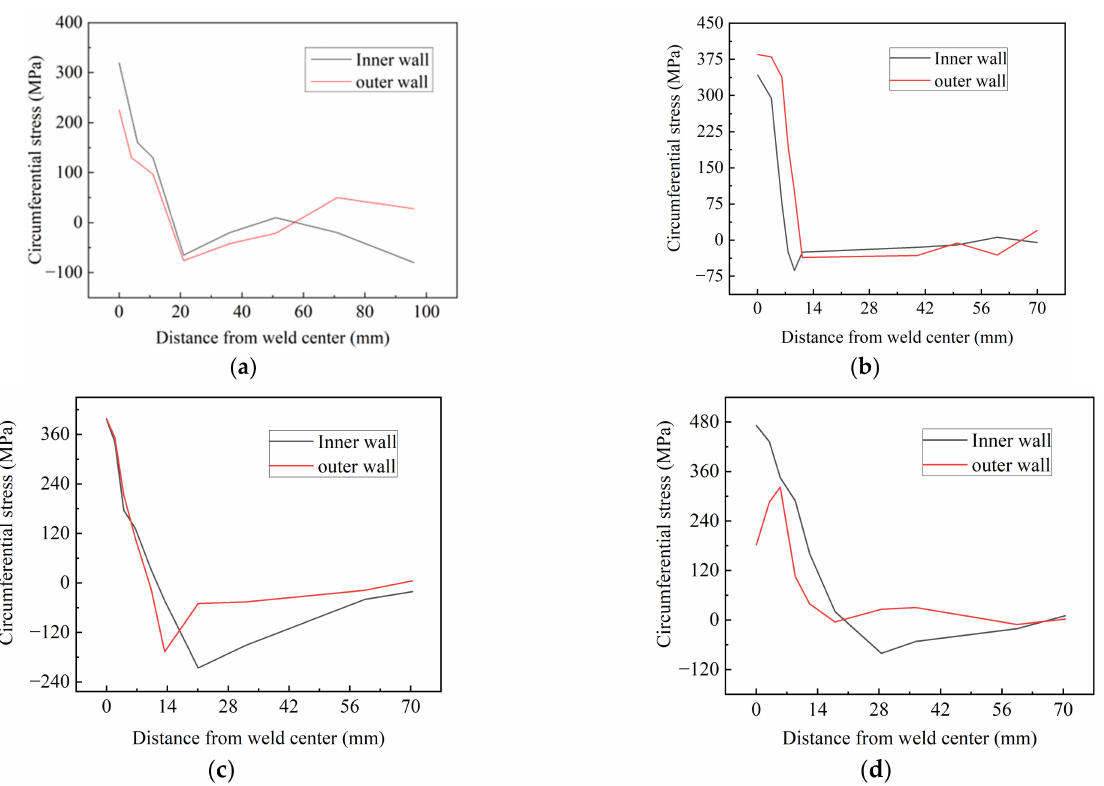
Figure 13. Circumferential stress distribution perpendicular to the weld direction with butt gaps